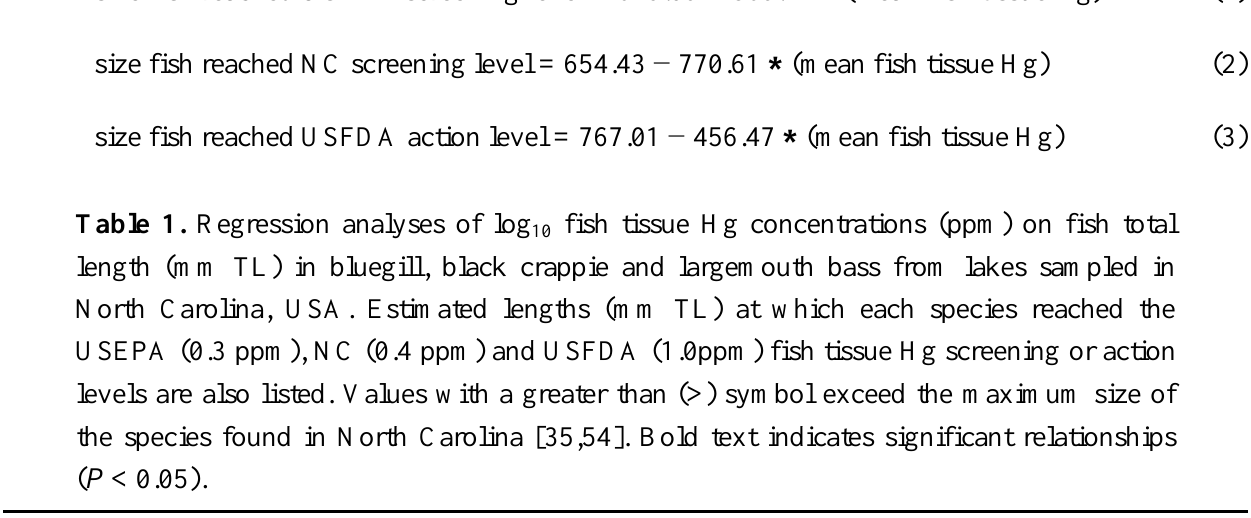
Table 1. Regression analyses of log fish tissue Hg concentrations (ppm) on fish total 10 length (mm TL) in bluegill, black crappie and largemouth bass from lakes sampled in North Carolina, USA. Estimated lengths (mm TL) at which each species reached the USEPA (0.3 ppm), NC (0.4 ppm) and USFDA (1.0ppm) fish tissue Hg screening or action levels are also listed. Values with a greater than (>) symbol exceed the maximum size of the species found in North Carolina [35,54]. Bold text indicates significant relationships ( P < 0.05). Estimated length at Hg levels for R 2 Equation EPA (0.3 ppm) (1.0 ppm)